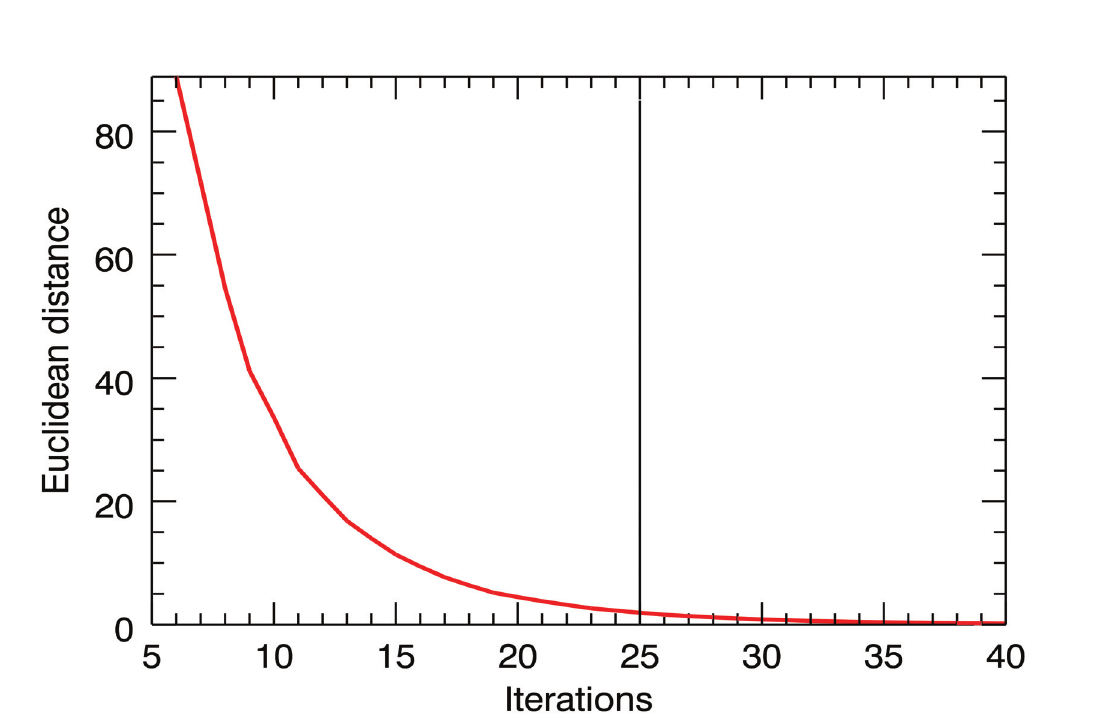
Figure 6: The median distance between the parameters found by PSFIT and those found by CURVEFIT for 50,000 photoactivation peak images as a function of the number of swarm iterations. The vertical line marks the iteration limit used in iPALM